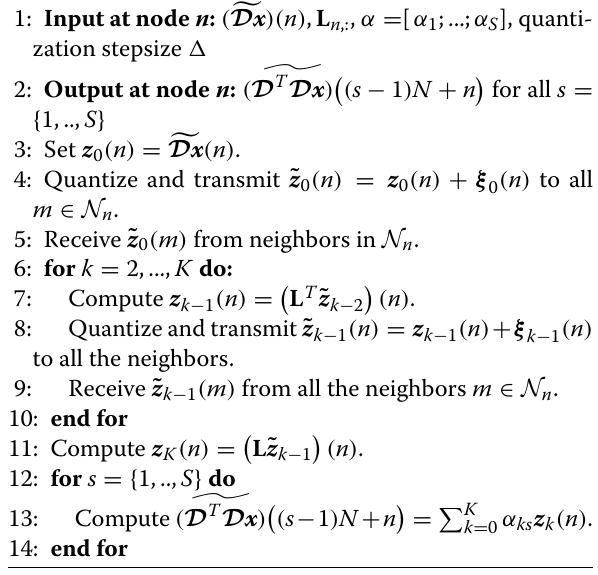
Algorithm 5 Distributed computation of D T D x with